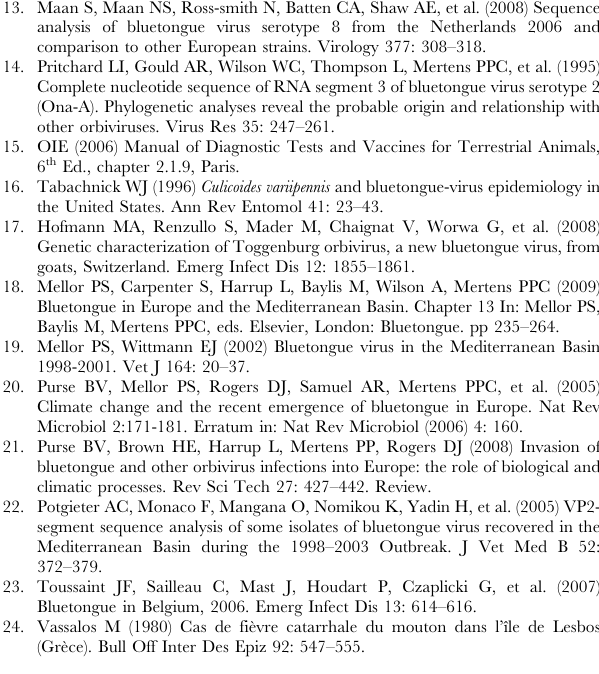
Figure S1 Phylogenetic tree inferred with maximum likelihood analysis using the 5 9 region of BTV Seg-3 (nucleotides 36 to 908) and the GTR + I + C model. The viruses included are indicated in tables 1 and 2. Isolate abbreviations: Serotype/origin (GRE: